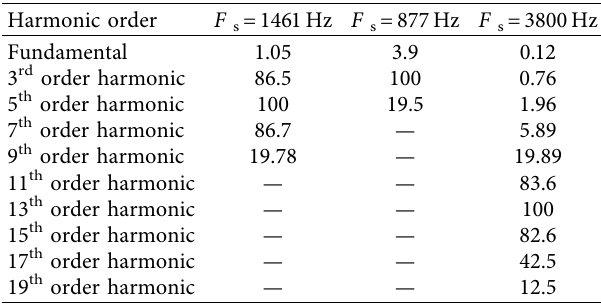
Table 2: Different values of pdet1 at various sampling